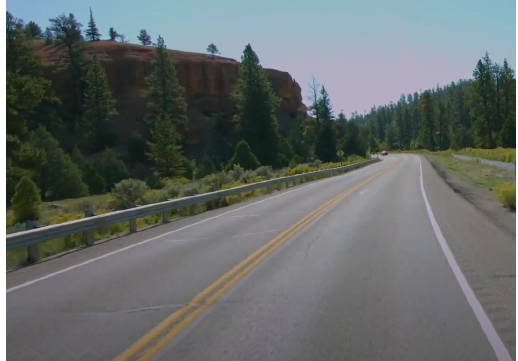
Figure 1. Parapets that may be detected as actual lane markers.